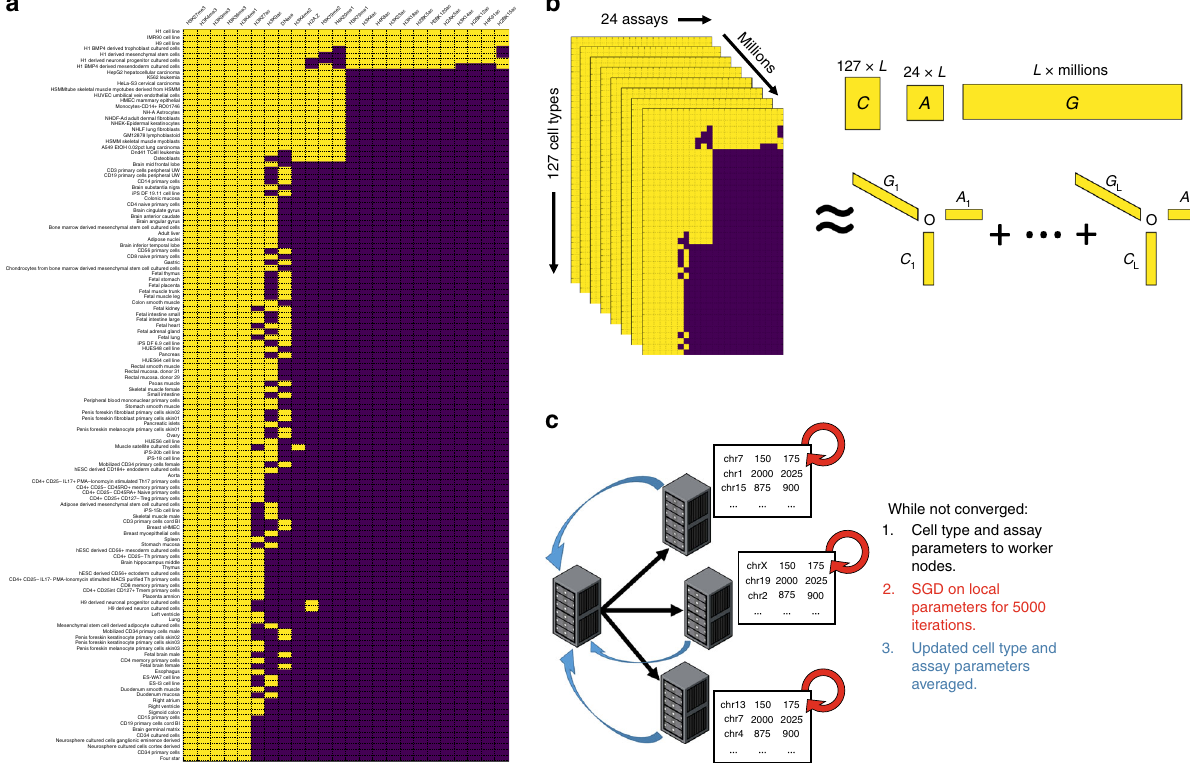
Fig. 1 Overview. a Matrix representing the subset of the Roadmap Epigenomics consolidated data set used in this study. Experiments in yellow have observed data, while missing experiments are purple. b We model the experiments in a as a three-dimensional tensor, and fi nd three low-rank factor matrices (denoted C , A , and G ) that can be combined by summing the outer products of each of the L latent factor vector triplets to reconstruct a complete tensor with no missing values that both approximates the existing data and imputes the missing data. c The genome dimension is very large, so in order to fi t all of the data in memory and to speed up training, we distribute the tensor across multiple cluster nodes running Apache Spark. Then we use parallel stochastic gradient descent 37 to share the A and C matrices across all